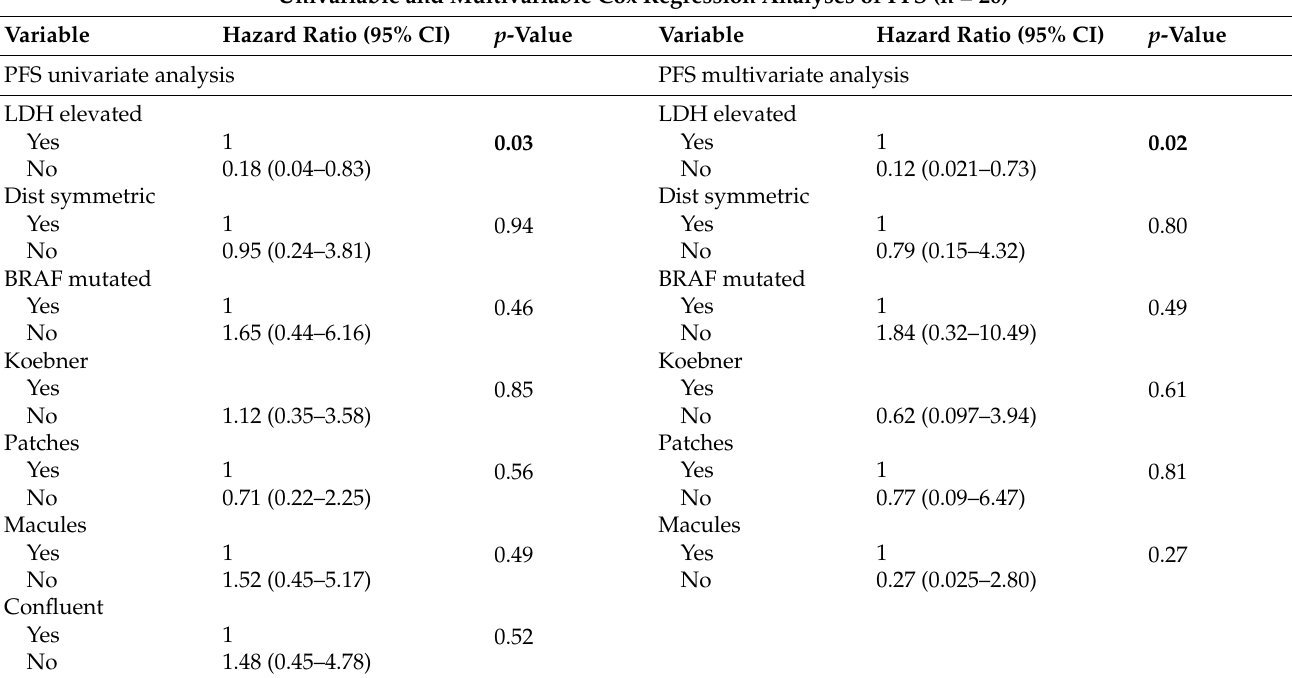
Figure 5. Time lapse between start of CPI and VLD onset. ( A ) Box plot showing a significant difference in the time lapse of VLD onset between patients with previous targeted therapy vs. no previous targeted therapy (** p < 0.001). ( B ) Box plot showing no significant time lapse of VLD onset of therapy responders vs. non-responders. Table 3. Univariable and multivariable Cox regression analyses of the progression-free survival. Univariable and Multivariable Cox Regression Analyses of PFS (n =